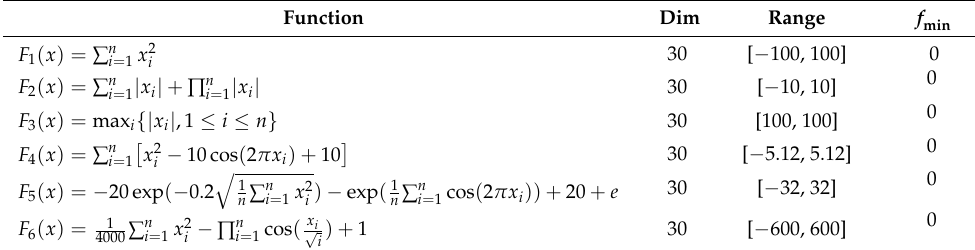
Table 3. Unimodal test functions and Multimodal test functions.